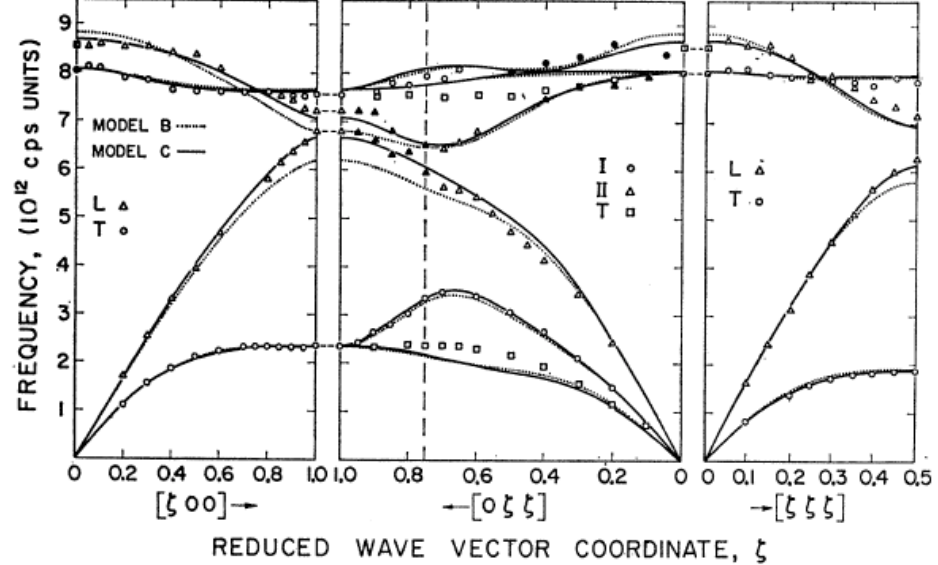
Figure 34. The phonon dispersion relations in gallium arsenide at 296 K. The solid points denote undetermined polarization. The vertical dashed line in the [0 ζζ ] direction represents the zone boundary. In this direction, points labeled I and II refer to modes whose polarization vectors lie within the (011) mirror plane. Other modes are strictly longitudinal (L) or transverse (T). The dotted and solid curves represent calculations based on two modifications of the dipole approximation or shell model. This figure is taken from Figure 1 of ref. [90]. Copyright by the American Physical Society.